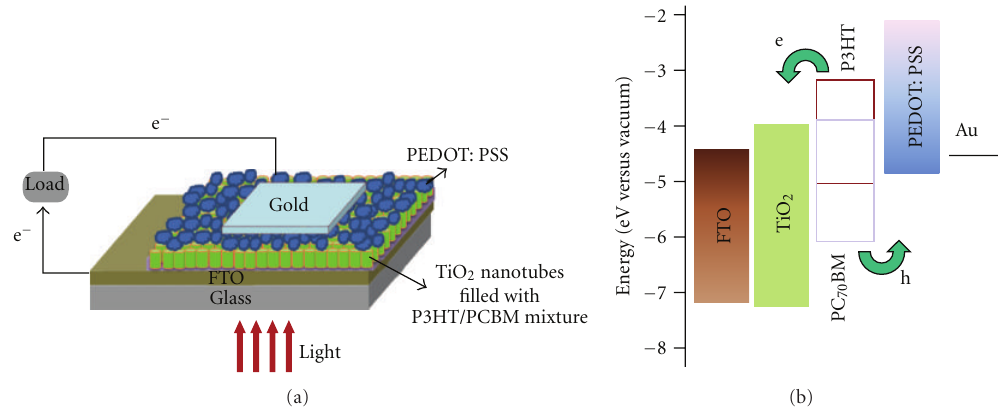
Figure 3: (a) Schematic device configuration of polymer TiO 2 nanotube-array-based solid-state solar cell, (b) HOMO and LUMO energies of the component materials of polymer TiO 2 nanotube-array-based solar cell. Reprinted with permission from [37].